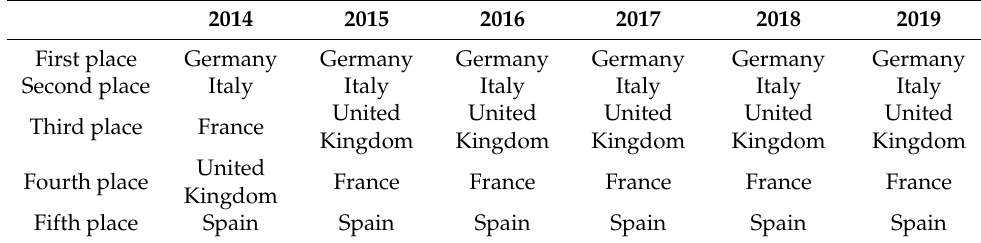
Table 3. European Union countries with maximum photovoltaic capacity in years